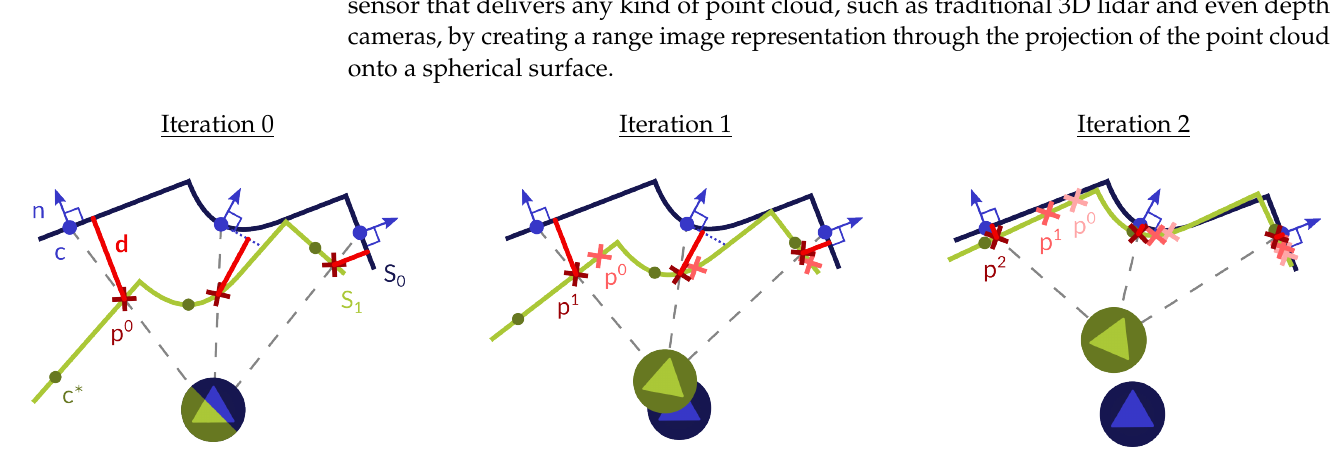
Figure 1. Consecutive iterations of the proposed algorithm. First, certain areas of the ordered scan S 0 (dark blue line) are selected based on their flatness. Planar patches defined by their center ( c , blue dot) and normal ( n , blue arrow) are fitted to the selection. These centers are projected (gray dashed lines) based on the current motion estimation onto S 1 (light green line), where the point ( p k , red cross) related to said plane can be extracted (with k representing the iteration). By imposing the coplanarity constraint [14], the relative pose of the sensor can be calculated as the rigid transformation that minimizes the point-to-plane distances ( d , red line) between each pair <point, plane>. In the next iteration, the estimated motion is used to update the point to which each plane is matched. This improves the probability of each pair fulfilling the coplanarity constraint, and thus results in a more accurate estimation of the movement. Notice how the selected point becomes closer and closer to its corresponding centroid ( c ∗ , dark green dots) with each